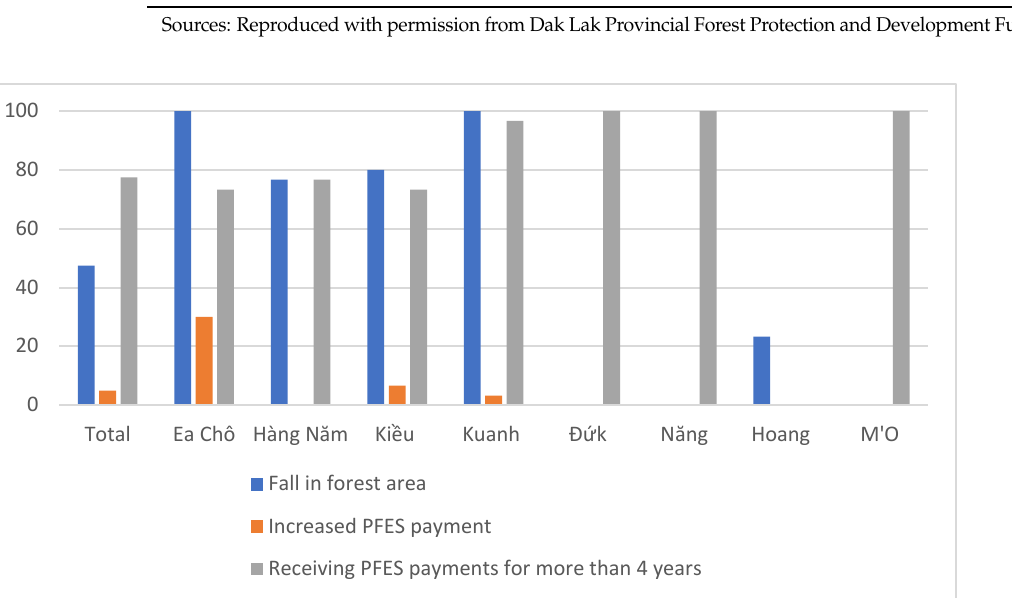
Figure 8. Forest and PFES status in study villages (% of respondents) in 2019. Sources: Household surveys (2021), [61].